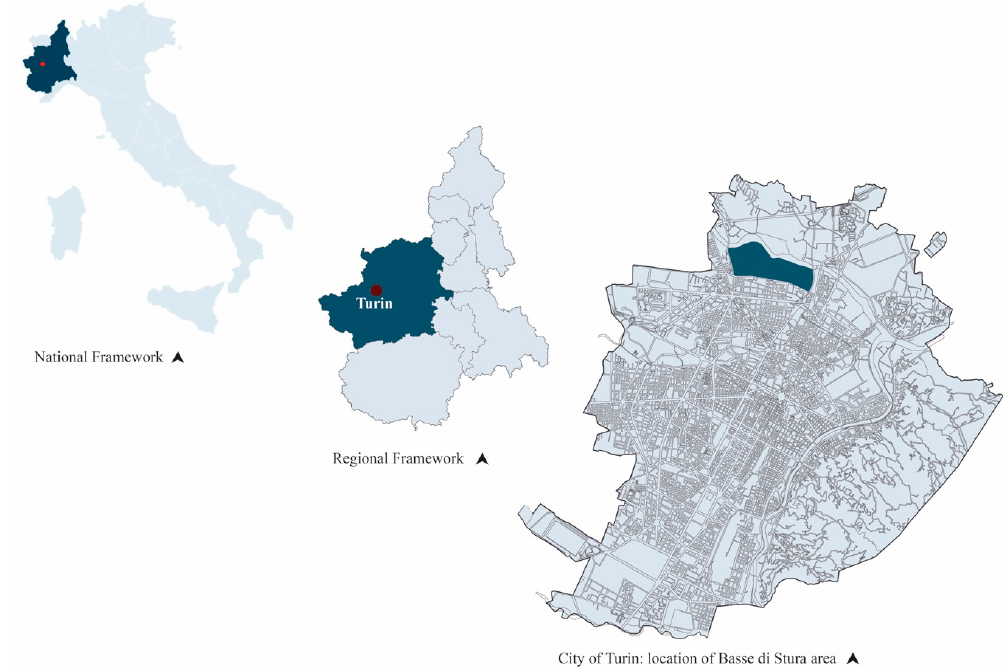
Figure 5. Territorial framework and identification of the area of Basse di Stura.